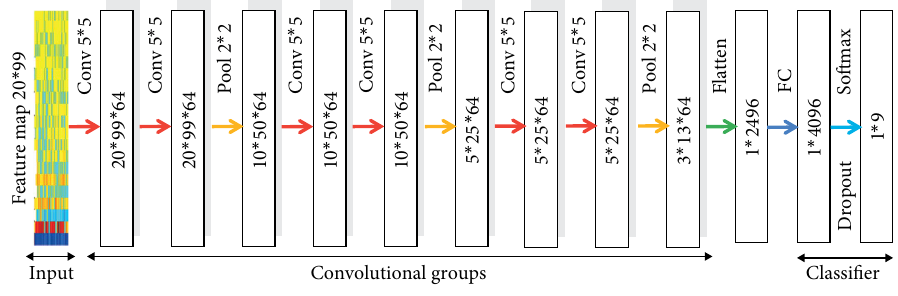
Figure 2: Proposed CNN